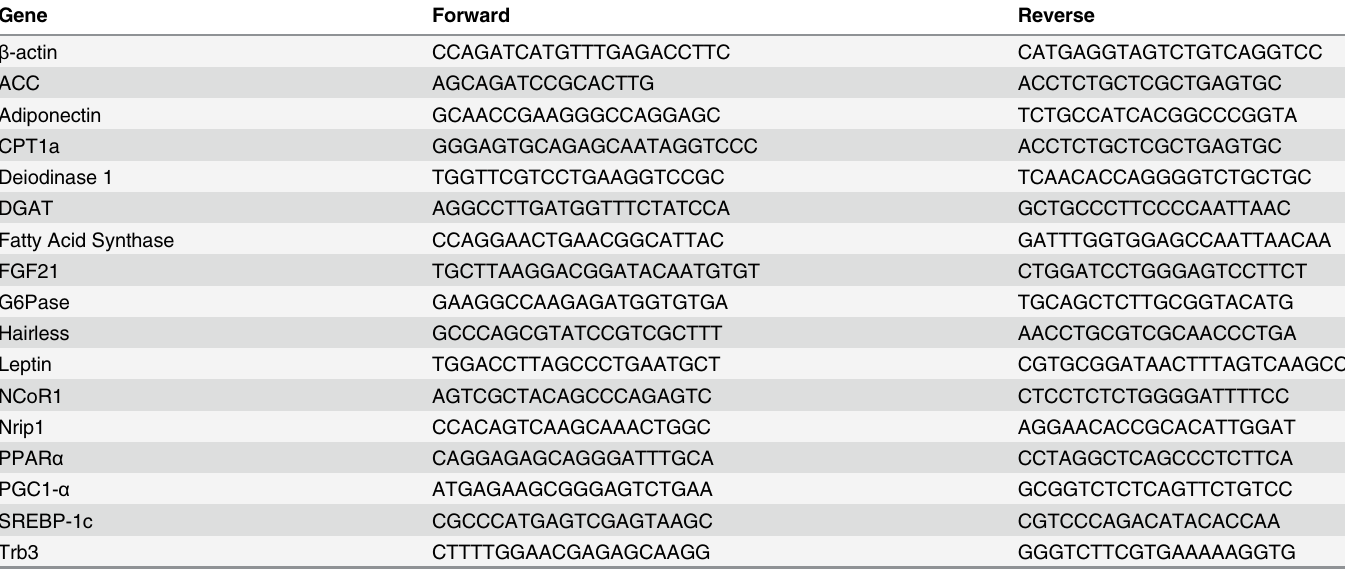
Table 1. qPCR primer sequences.